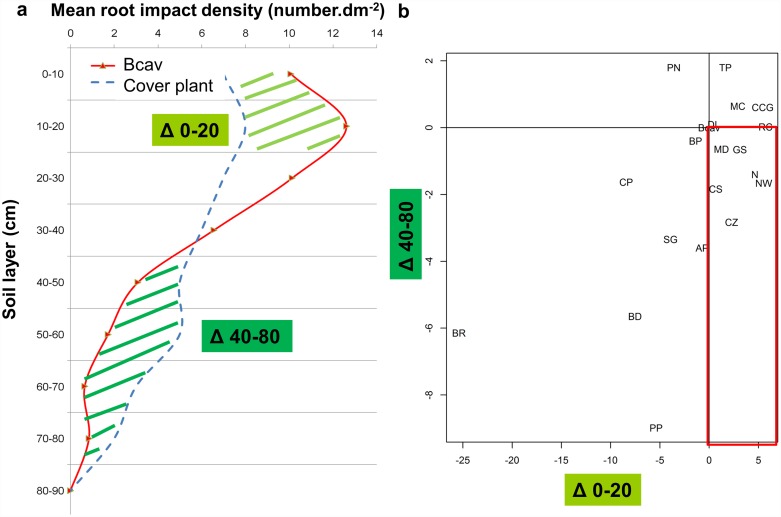
Species distribution according to differences in root-impact density between the cover plant species and the Cavendish banana cultivar (Bcav) in two soil layers (0–20 cm and 40–80 cm).a Banana root-impact density profile (red line) and root-impact density profile of an ideal cover plant species (blue dashed line) which is complementary to the banana profile, i.e. with a positive Δ0–20 (lower root-impact density than banana) and negative Δ40–80 (higher root-impact density than banana). b Species distribution according Δ0–20 and Δ40–80. The area outlined in red corresponds to the root-impact density profile required for associations with banana. See Table 2 for the species names.